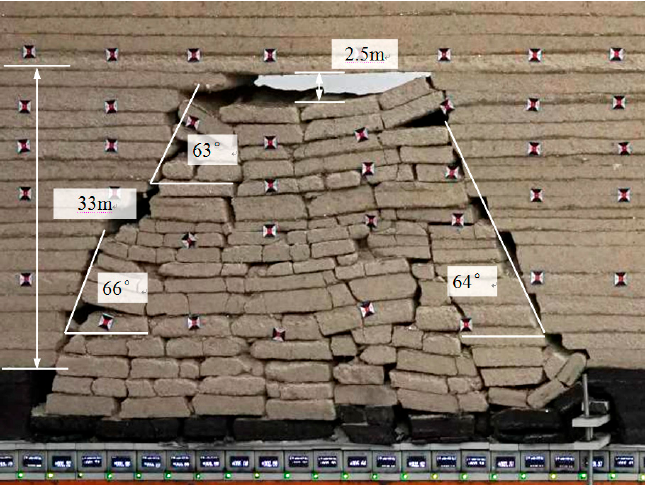
Figure 22. The working face advanced to 68m